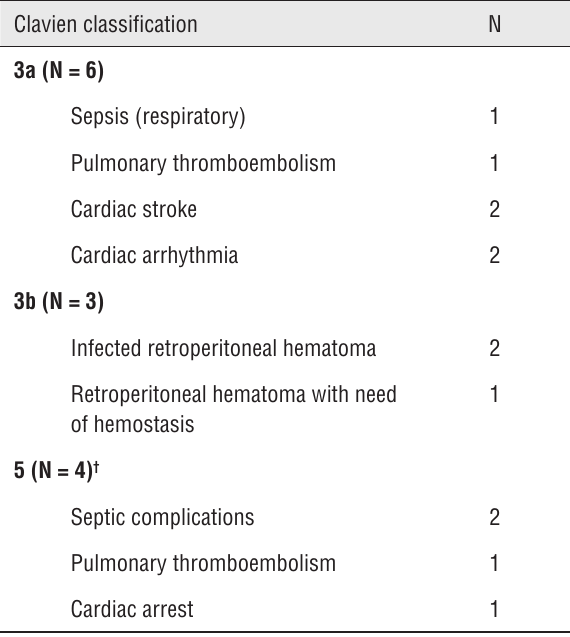
Table 5 – Post-operative major complications (N =